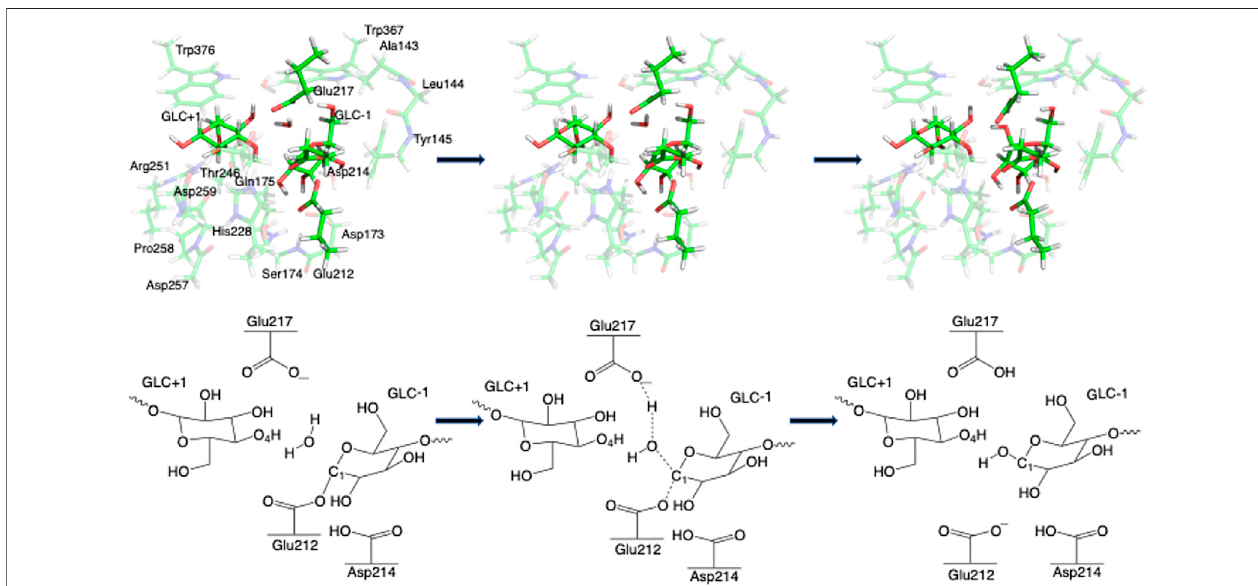
FIGURE 7 | 3D and 2D representation of deglycosylation reaction mechanism of the Res21-E model of 8CEL.